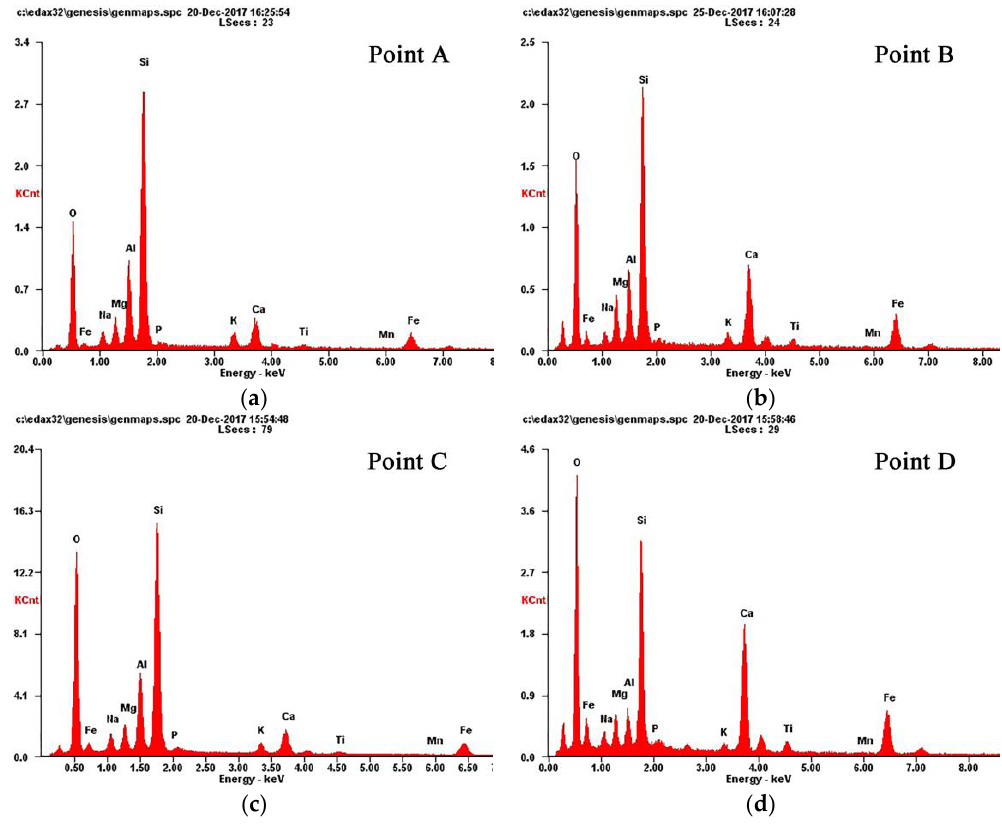
Figure 10. EDS results of basalt fibers: ( a ) Point A ; ( b ) Point B; ( c ) Point C and ( d ) Point D.